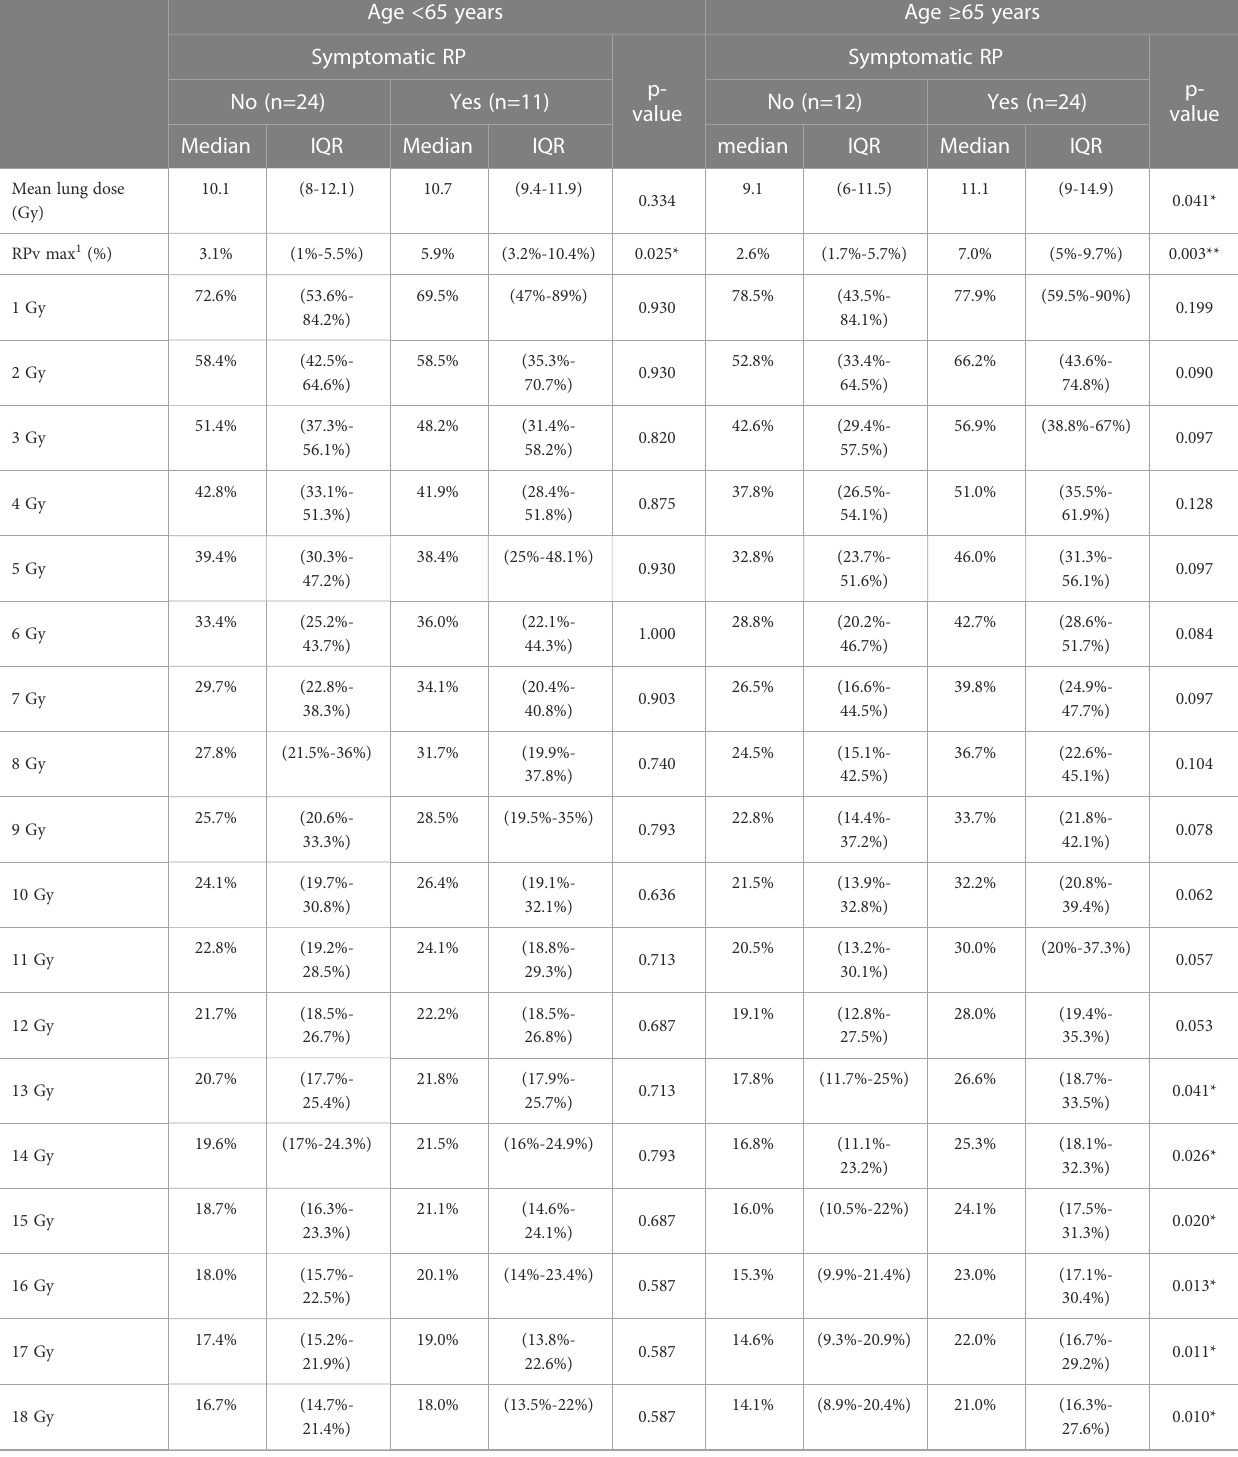
TABLE 6 Symptomatic RP in the <65 and ≥ 65 years age